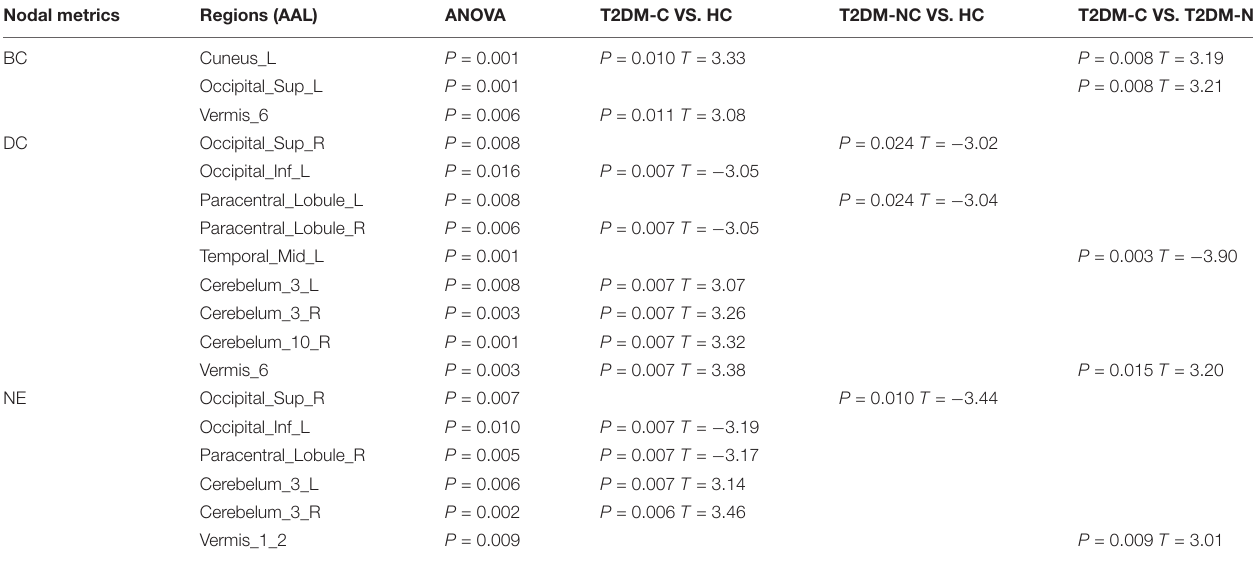
TABLE 2 | The significant differences in nodal topological metrics of AUC.